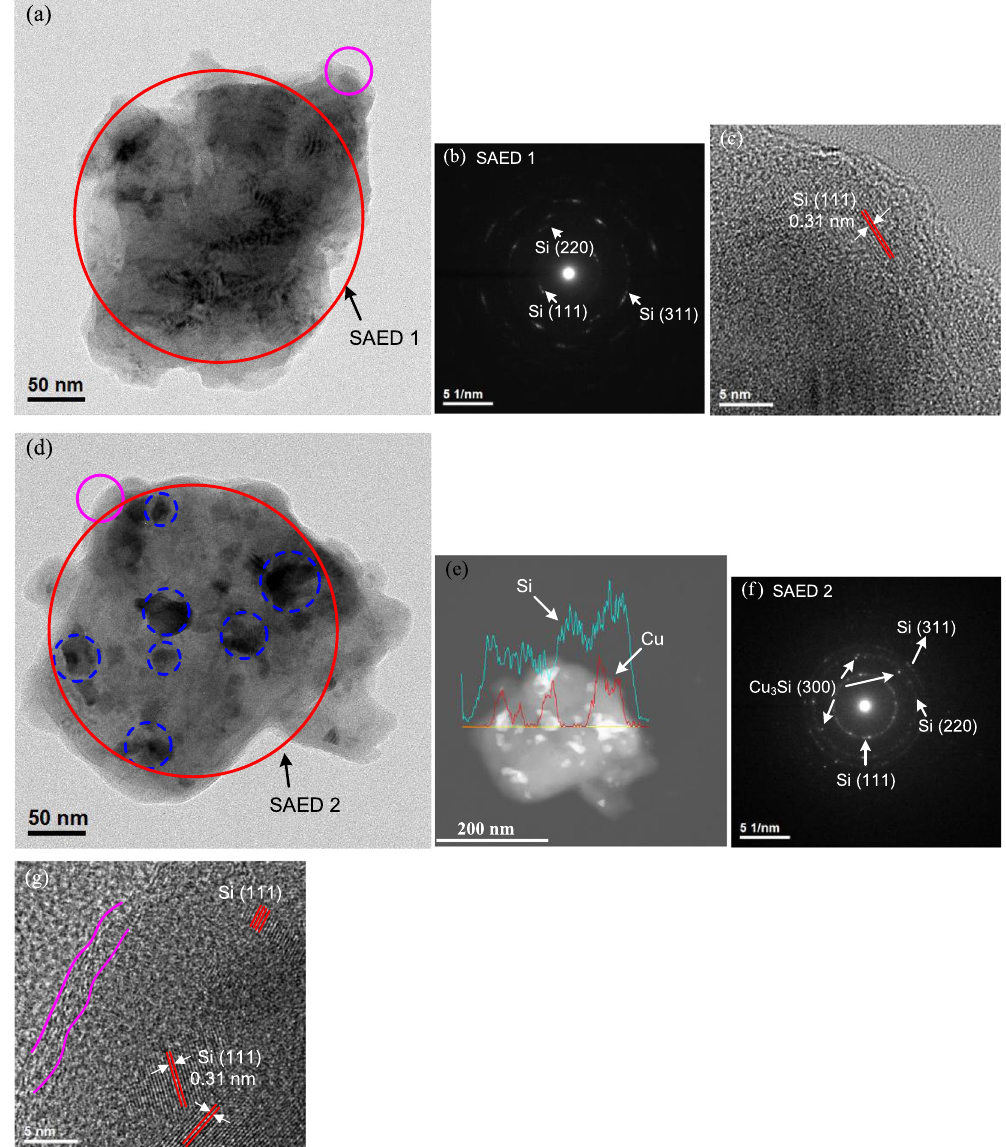
Figure 3. ( a ) TEM image of SCV H + W aggregate, ( b ) SAED 1 pattern, ( c ) HRTEM image referred to pink cycle in ( a) , ( d ) TEM image of C-SCV H + W aggregate, ( e ) corresponding high-angle annular dark-field image of ( d) , ( f ) SAED 2 pattern and ( g ) HRTEM image referred to pink cycle in ( d